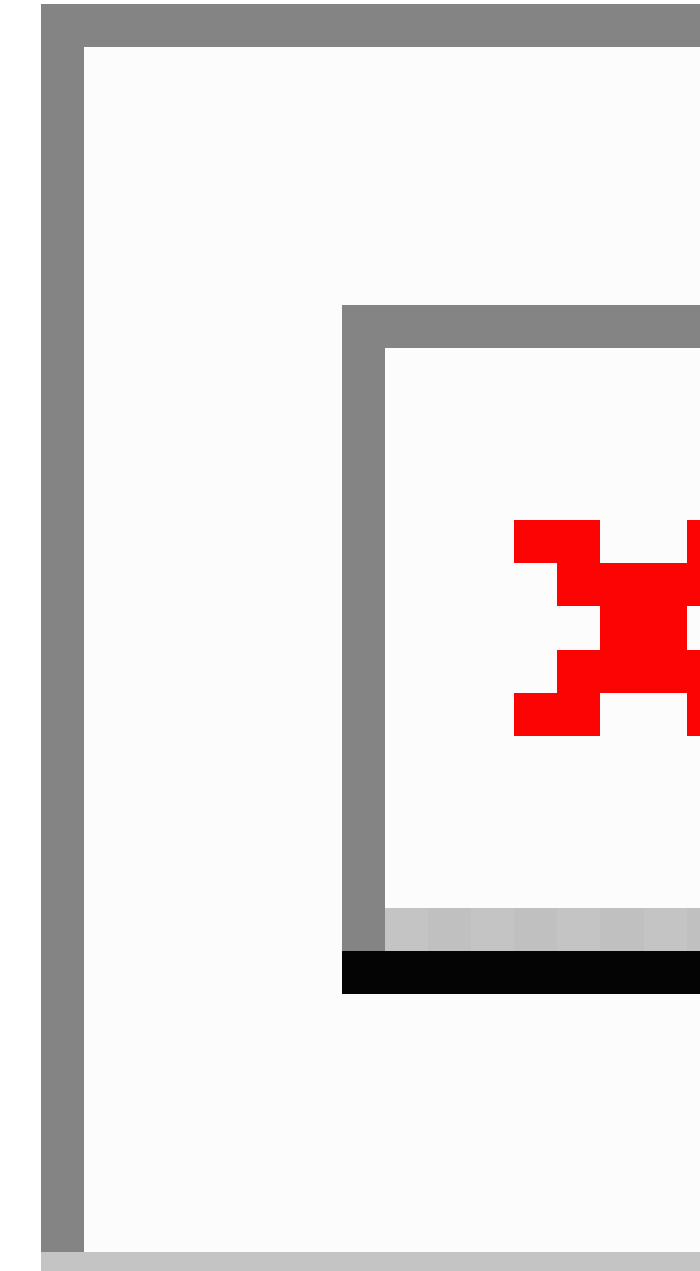
Figure 1. Illustration of the interaction of smoking and cancer treatment/late